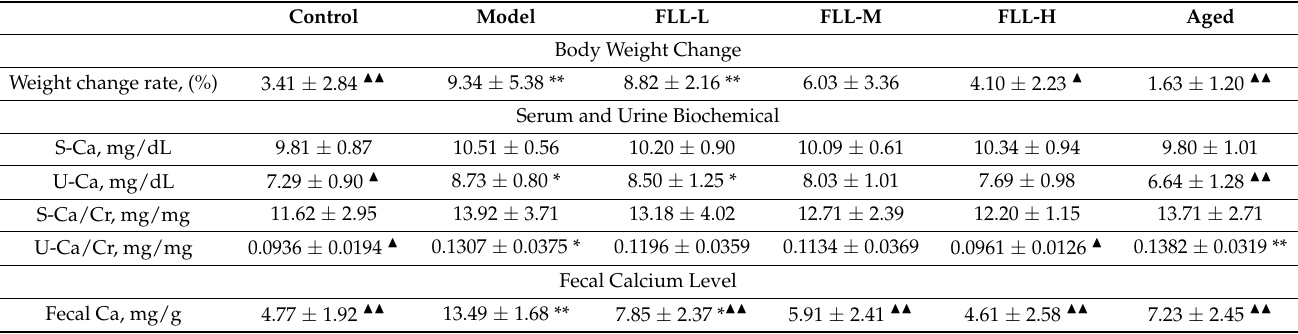
Table 1. Effects of Fructus Ligustri Lucidi (FLL) on body weight, biochemical parameters, and fecal calcium in female mice. Control Model FLL-L FLL-M FLL-H